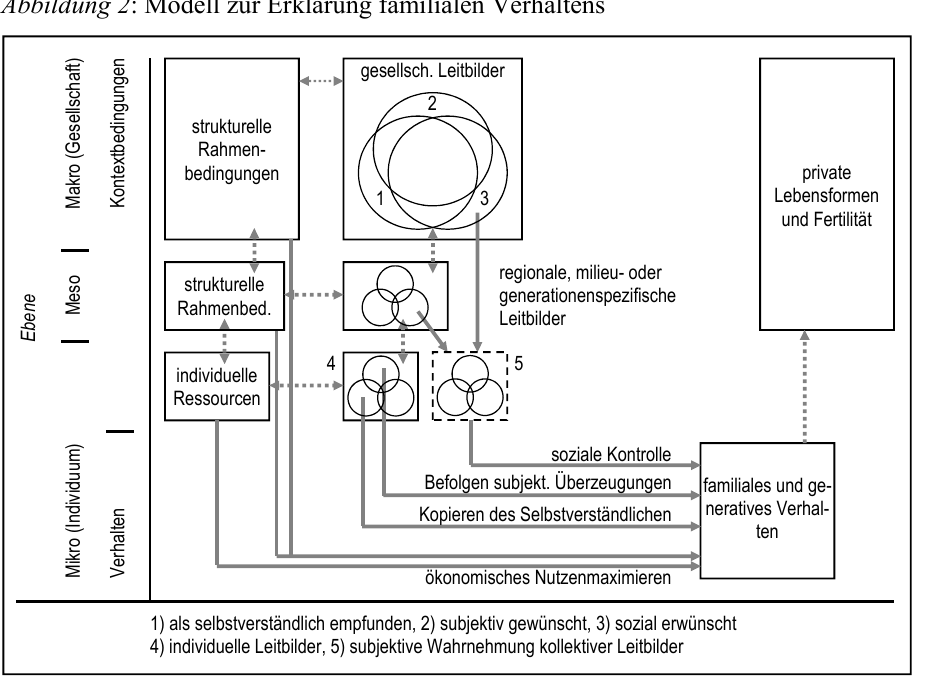
Quelle : eigene schematische